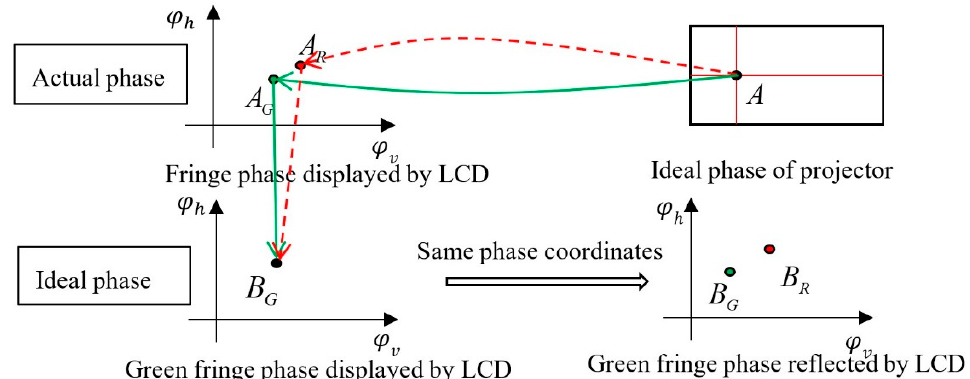
Figure 4. Schematic diagram of ideal phase of the red